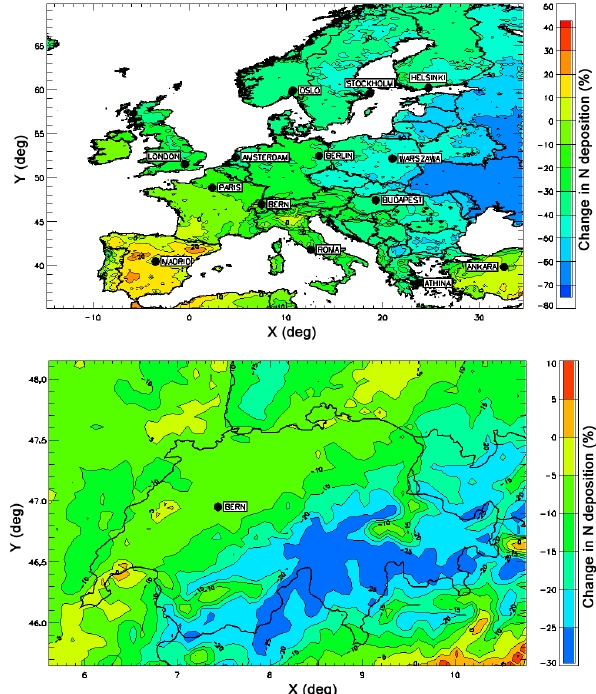
Figure 16. Relative changes in nitrogen deposition over the Euro- pean (upper panel) and Swiss (lower panel) domains,